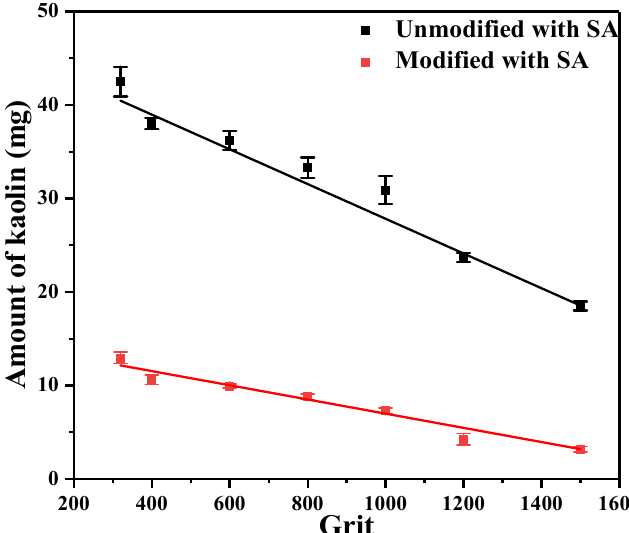
ff erent grit SiC